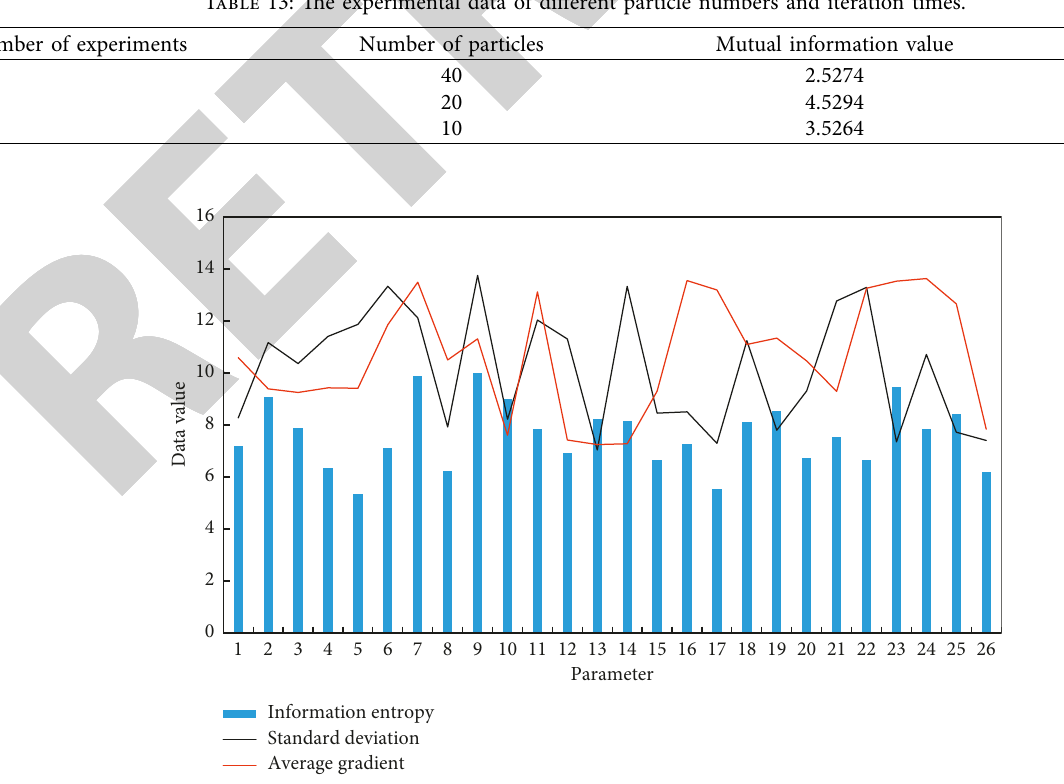
Figure 11: Objectively evaluate the fusion